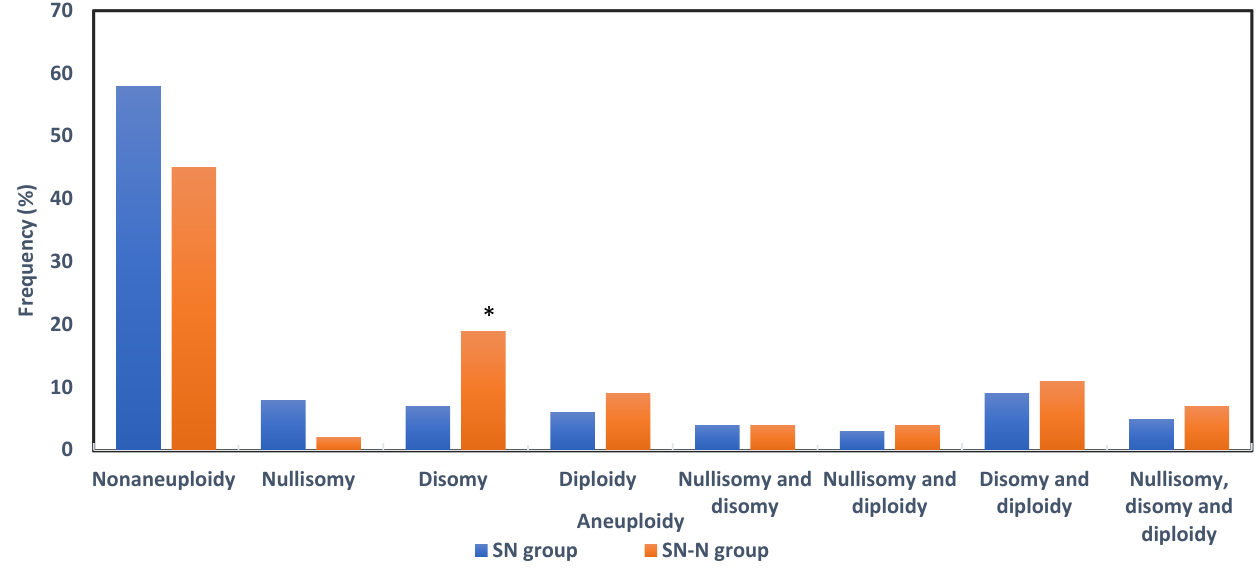
Figure 7. Frequency of aneuploidies after FISH analysis (SN = subfertile population with normozoospermia; SN-N = subfertile non-normozoospermic population). * Fischer’s exact test p = 0.0108.